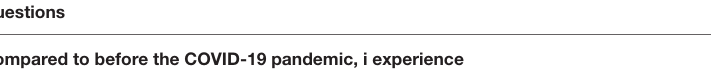
TABLE 1 | Mental health symptoms and balance work and private during the COVID-19